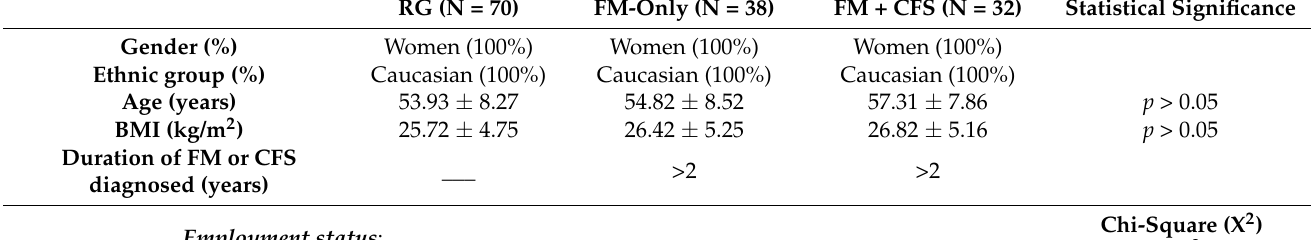
Table 1. Anthropometric characteristics, employment status, and the most common comorbidities of the participants.